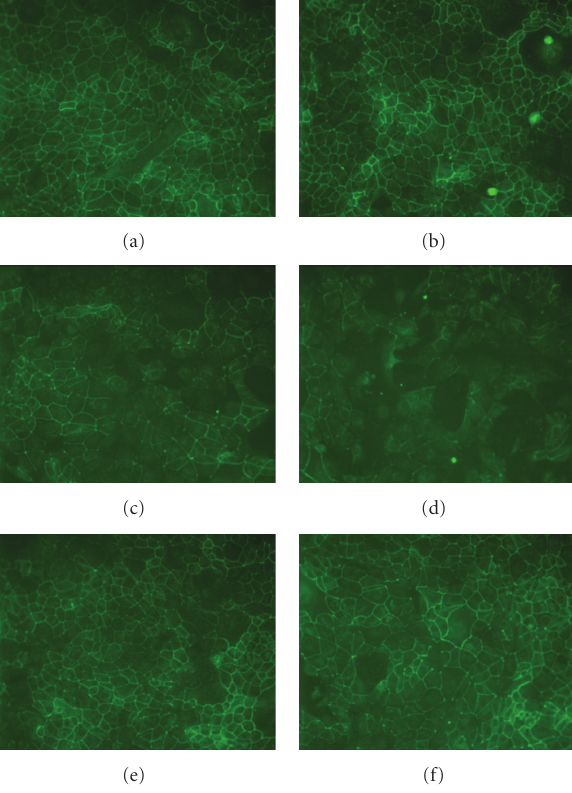
Figure 2: Hypercholesterolemic serum could alter the distribution of ZO-1 in endothelial cells, which seemed to be dose dependent. PI3K specific inhibitor wortmannin could significantly reverse the e ff ect induced by hypercholesterolemic serum. (a) serum free medium; (b) normal rabbit serum; (c) low concentration of hyper- cholesterolemic serum (0.04 mMol/L); (d) high concentration of hypercholesterolemic serum (0.32mMol/L); (e) c plus 100 nMol/L wortmannin; (f) d plus 100 nMol/L